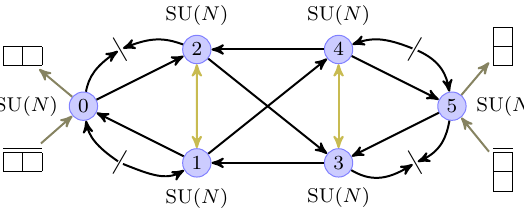
Figure 19. The quiver for the orientifold theory of L 0 , 6 , 0 / Z 2 → L 2 , 4 , 2 / Z 2 → L 3 , 3 , 3 / Z 2 in Family A with choice ( τ 00 = + , τ 55 = − ) . Colored fields represent the pairs that are mass deformed in the chain, the color match the chain of five-branes in figure